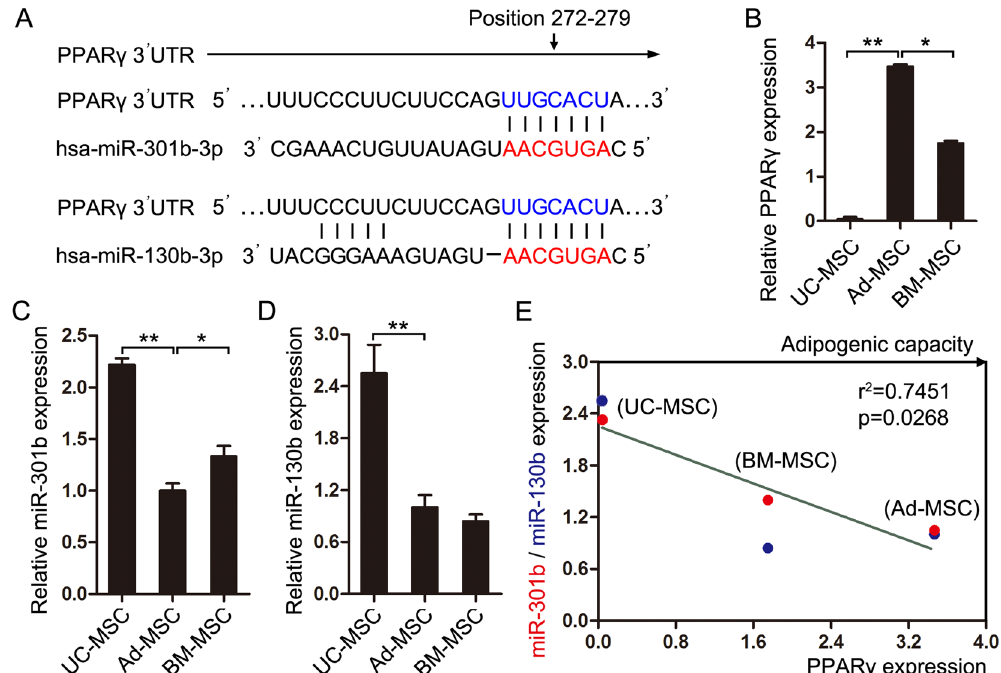
Figure 5. MiR-301b~miR-130b—PPAR γ expression pattern correlate with the adipogenic capacity of the three sources-derived MSCs. ( A ) The binding sites of miR-301b~miR-130b in PPAR γ 3 ′ UTR were shown. ( B – D ) The expression of PPAR γ , miR-301b and miR-130b were detected in UC-MSC, Ad-MSC and BM-MSC. ( E ) The correlation of miR-301b/miR-130b expression with PPAR γ expression in the three sources-derived MSCs was performed using linear regression analysis. * P < 0.05 and ** P < 0.01, Student’s